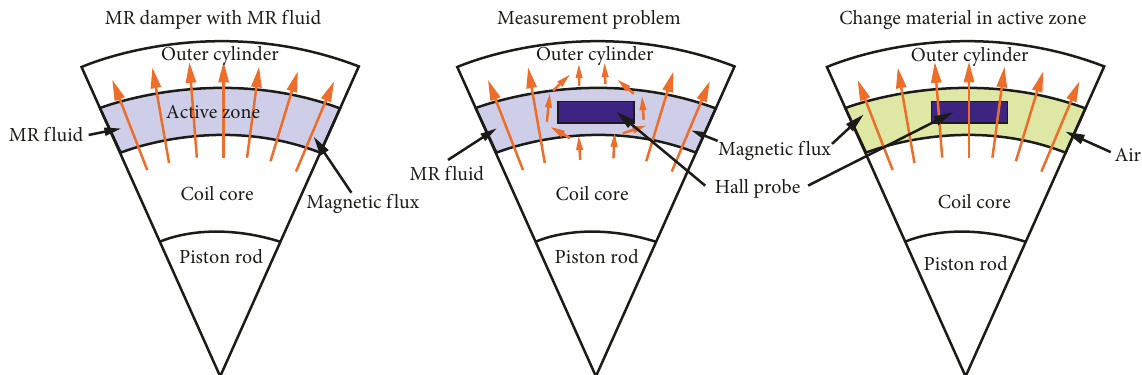
Figure 10: Illustration of the measurement problem with Hall sensor in the annular gap in the presence of MR fluid